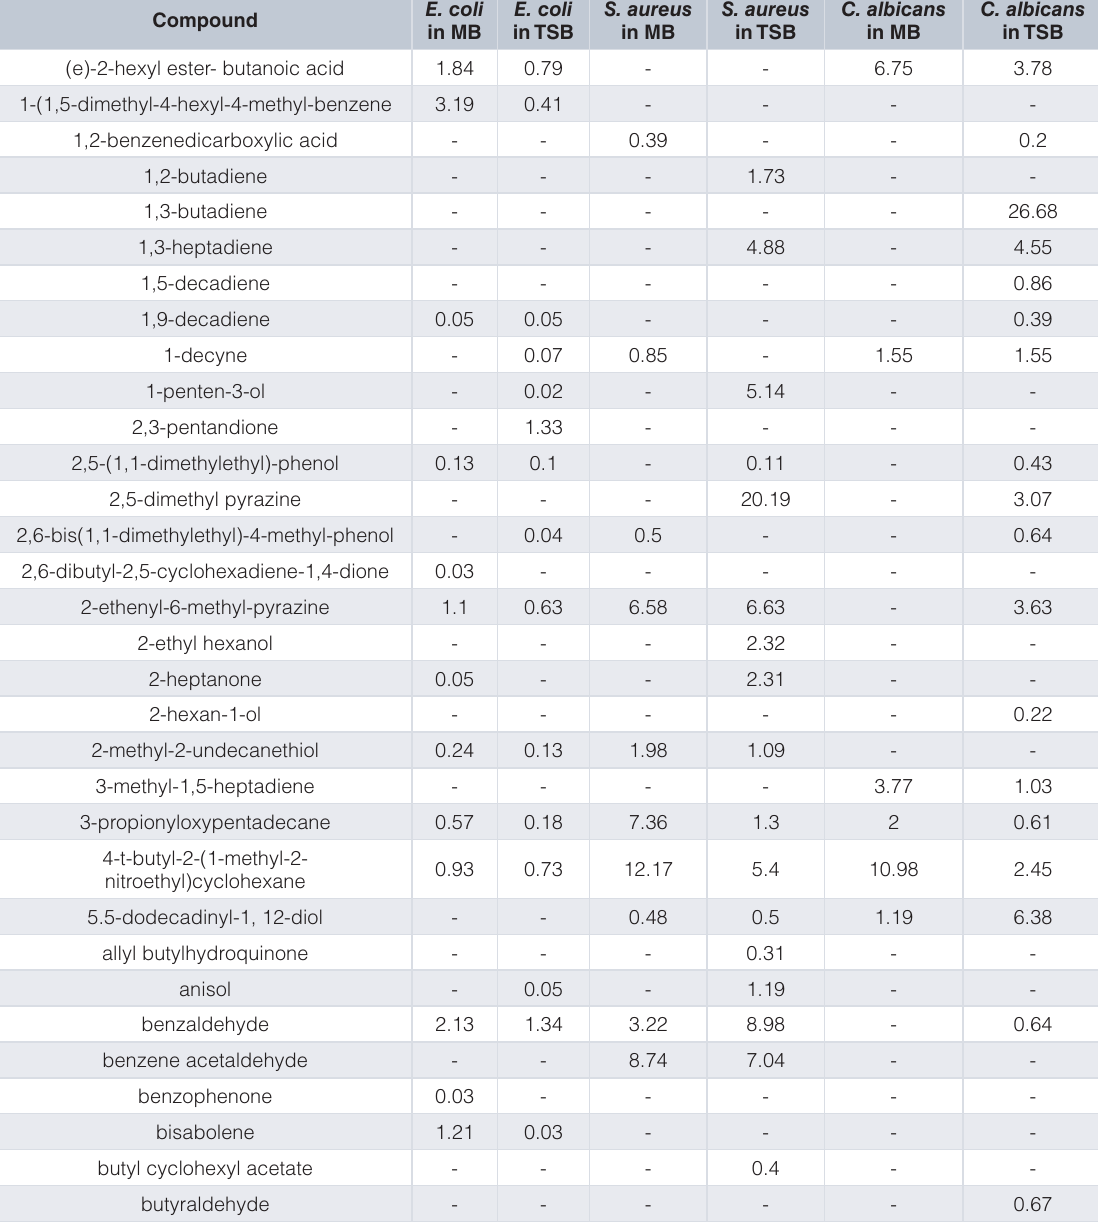
Table 1. The identified VOCs for E. coli , S. aureus and C. albicans, and the percentage of the total area that their average peak covered (peak area %), after 2hours in MB and TSB media. In total, ��� types of ��Cs byIn total, ��� types of ��Cs by E. coli , 33 types by S. aureus and �8 types by C. albicans were generated in this